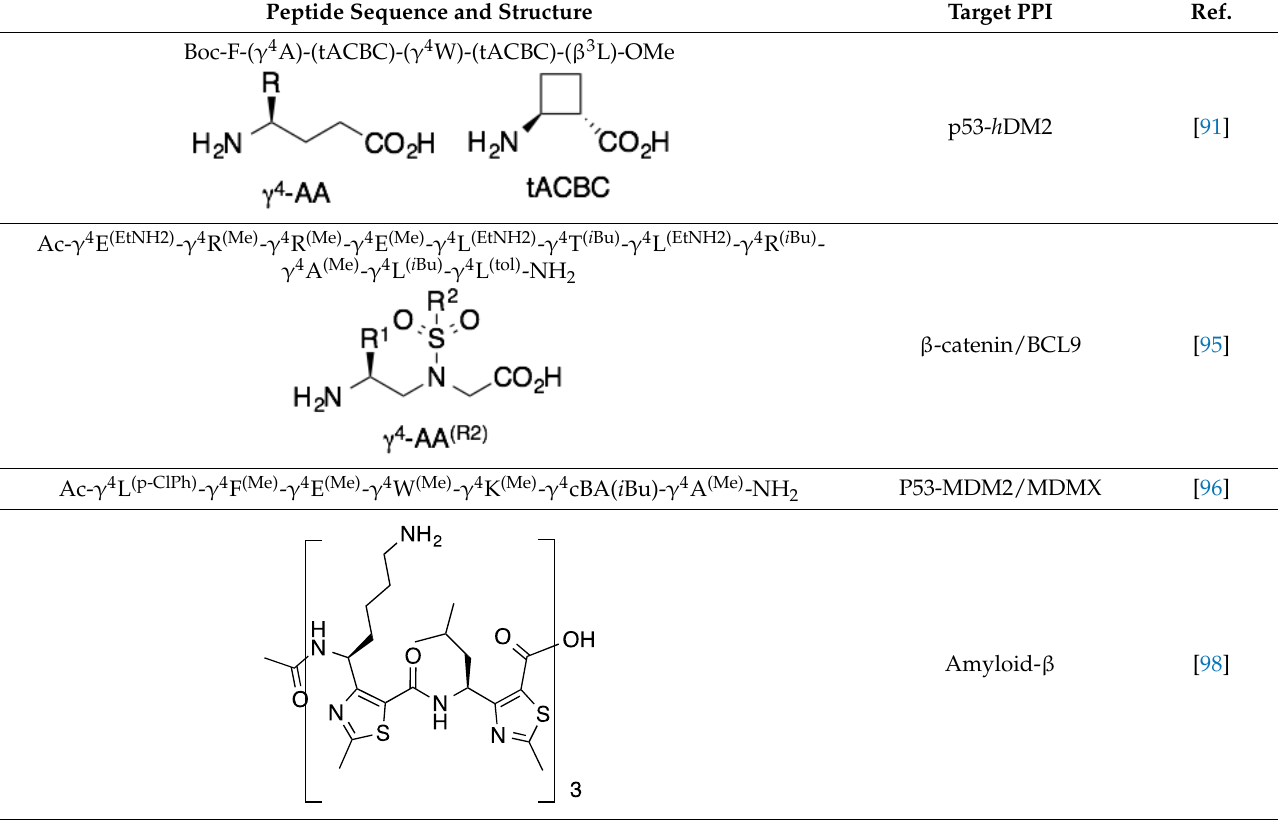
Table 3. γ -peptides as PPI inhibitors. Peptide Sequence and Structure